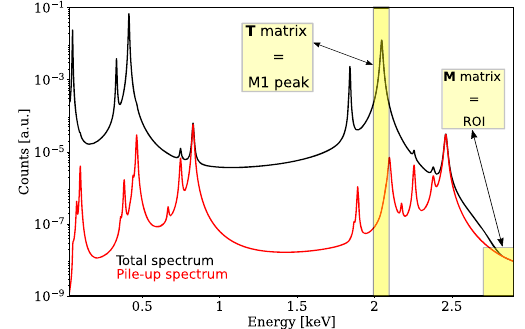
Fig. 5 De-excitationsimulatedspectraof 163 Howith f tot pp = 3 × 10 − 3